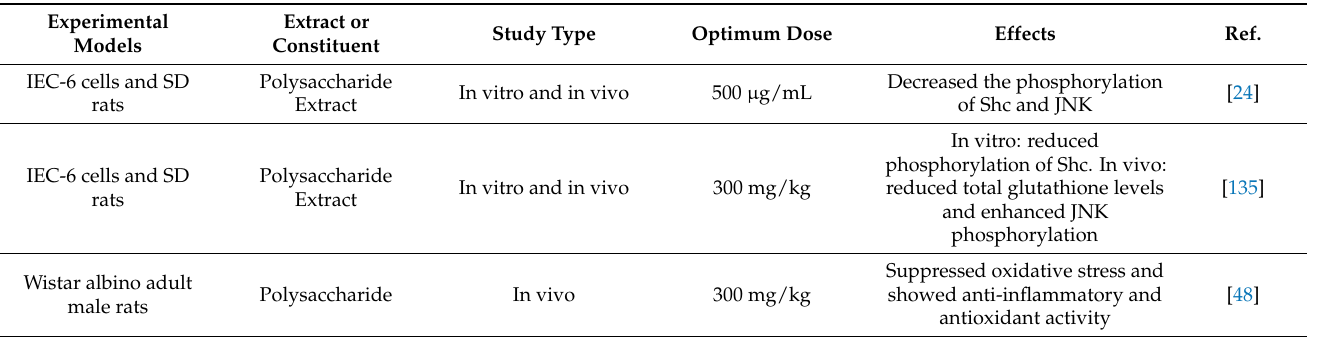
Table 14. Summary of the gastroprotective activity of H. fusiformis